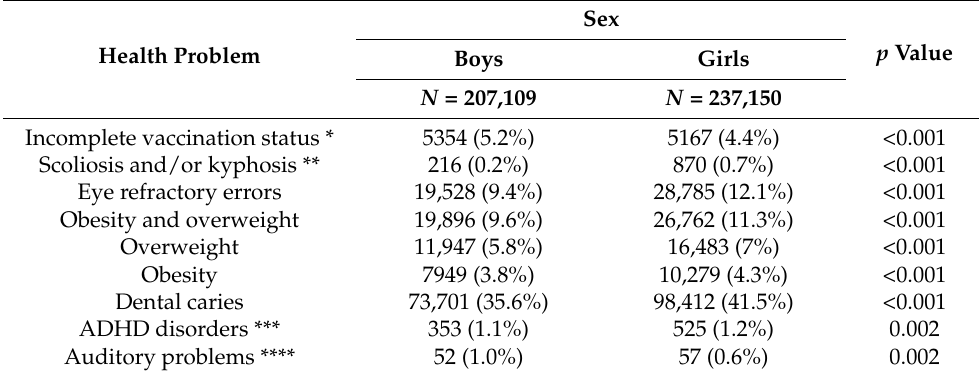
Table 3. The association of health problems with sex of screened primary school students ( N =